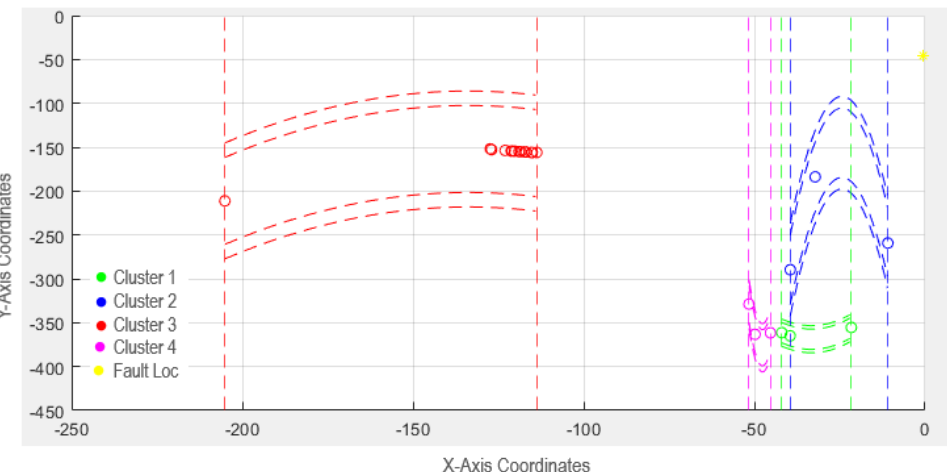
Figure 20. 10 Ω fault identified.